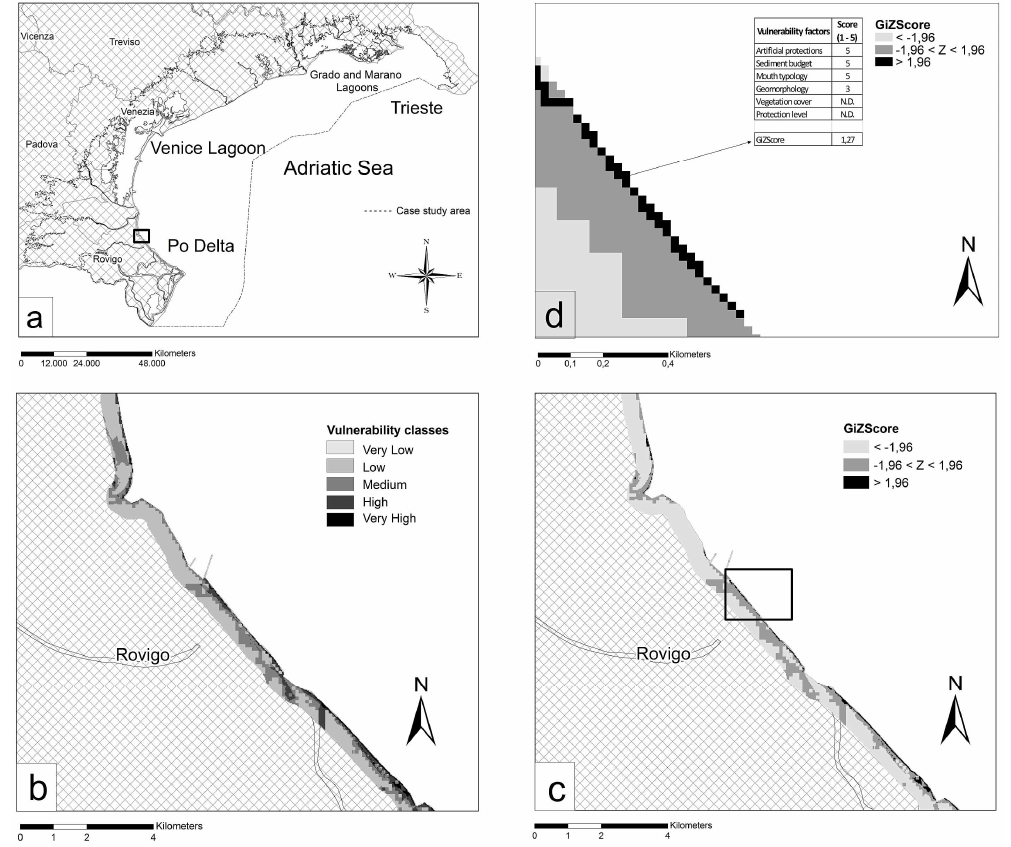
Fig. 9. Vulnerability map for the river mouth receptor related to the coastal erosion impact on the North Adriatic coast (a) and in a specific area of the Po River Delta (b) . Maps representing the hot spots analyzed in the zoomed area of the Po River Delta (c) and a detailed hot spot with its contributing vulnerability scores (d)